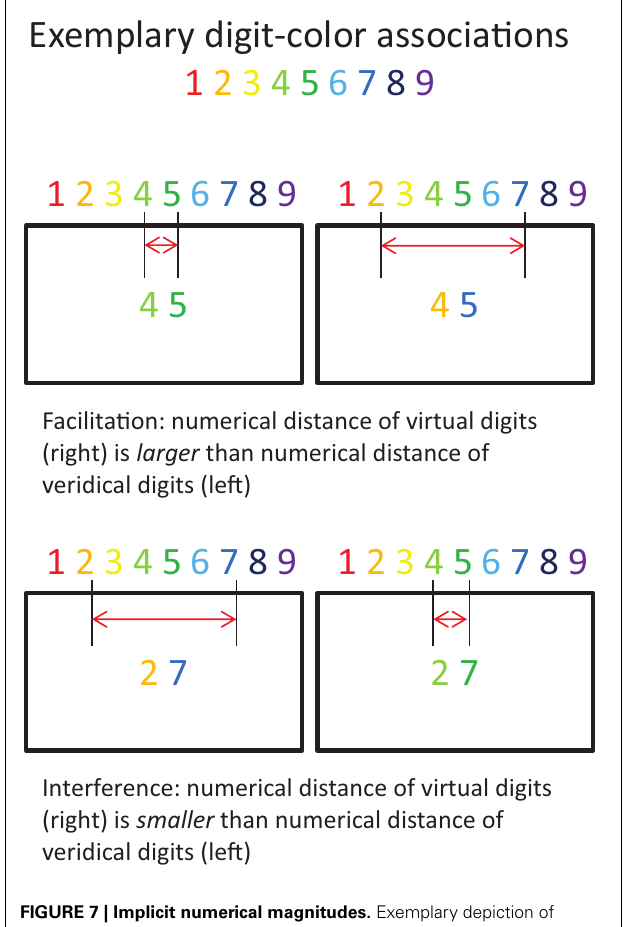
FIGURE 7 | Implicit numerical magnitudes. Exemplary depiction of experimental conditions: Facilitation and interference effects due to activation of implicit numerical magnitudes via color information. The red horizontal arrows represent the virtual numerical magnitude as indicated by the colors. Adopted from Cohen Kadosh et al.